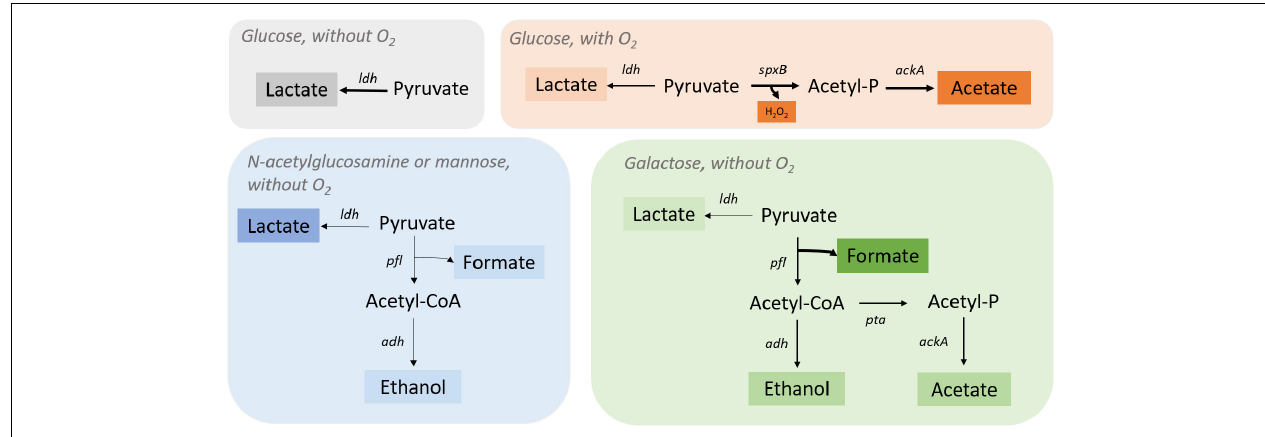
FIGURE 2 | Streptococcus pneumoniae R6 pyruvate metabolism under different environmental conditions. Pyruvate is fully converted into lactate by lactate dehydrogenase (Ldh) when glucose is present, and oxygen is absent. In the presence of oxygen, S. pneumoniae R6 switches to a heterofermentative profile by activating the spxB (pyruvate oxidase) gene to produce acetate and H 2 O 2 together with lactate (in minor quantities). In the presence of n -acetylglucosamine or mannose (without O 2 ), the ldh gene is fully activate leading to the production of lactate as major fermentation product and pfl (pyruvate formate-lyase) genes are only partially activated, as shown by the minor quantities of acetate, ethanol, and formate. In the presence of galactose, formate is the major product of fermentation revealing a complete activation of the pfl genes. Ethanol and acetate are also produced, ethanol by the action of alcohol dehydrogenase (Adh) and acetate from acetyl-CoA production by phosphate acetyltransferase (Pta) and acetate kinase